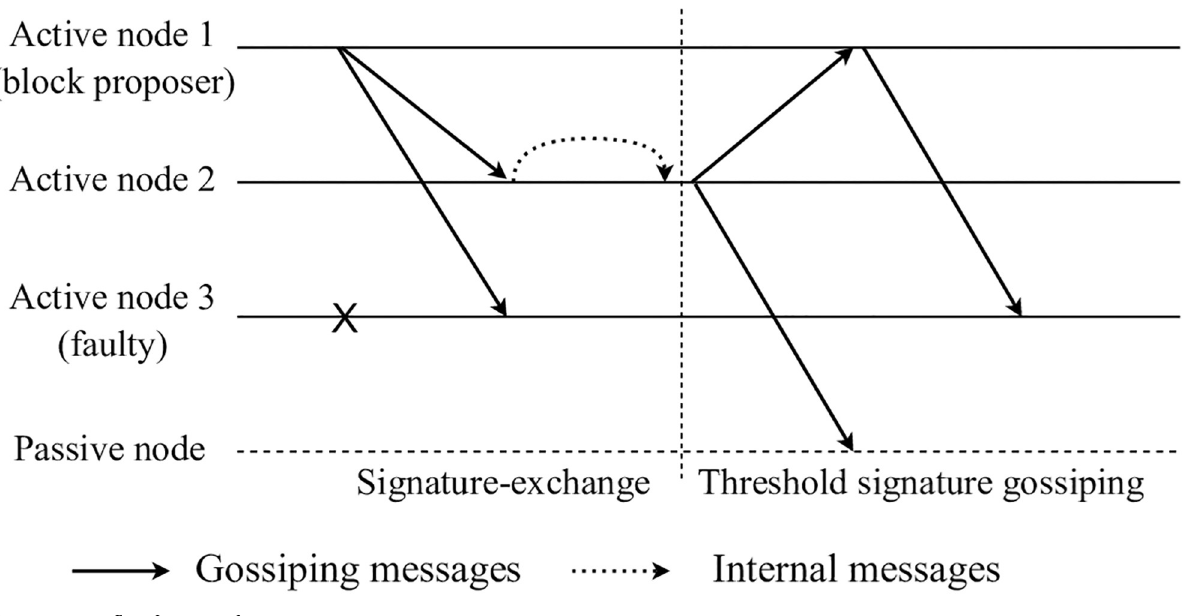
Fig 4. Message flow for n = 4, f =